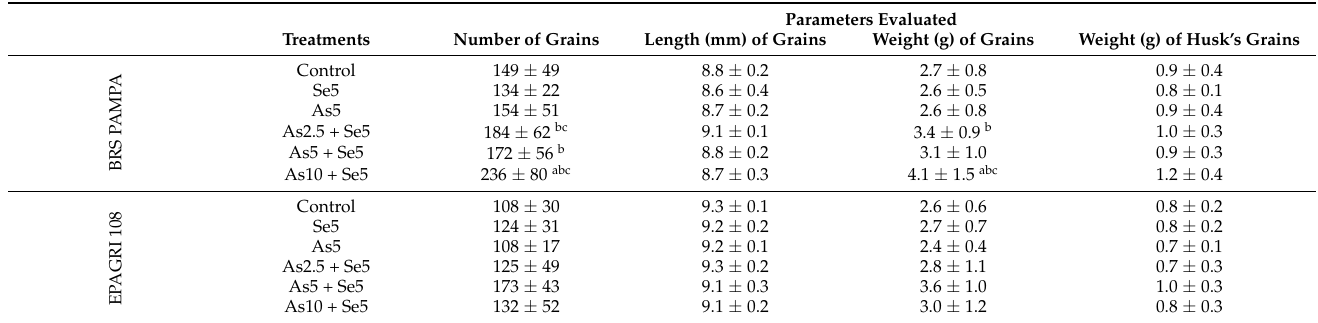
Table 1. Agronomic parameters of the grains harvested after complete maturation of the cultivars BRS Pampa and EPAGRI 108. Results are expressed as mean ± standard deviation (n = 5); a,b,c : significant statistical differences at p < 0.05.